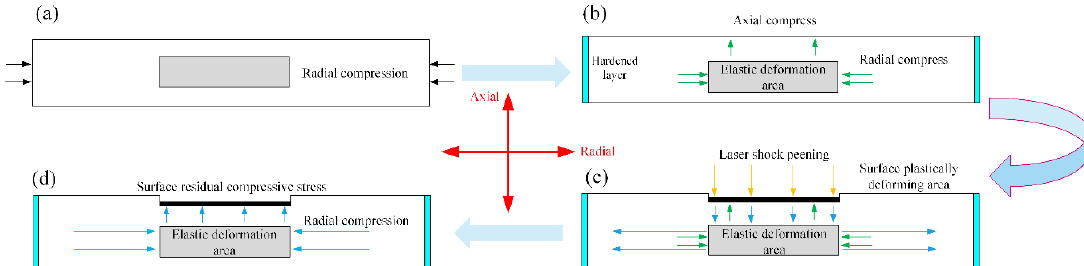
Figure 5. Schematic diagram of the internal stress state of materials before and after laser shock peening: ( a ) during extrusion; ( b ) end of extrusion; ( c ) during laser shock peening; ( d ) end of laser shock peening.